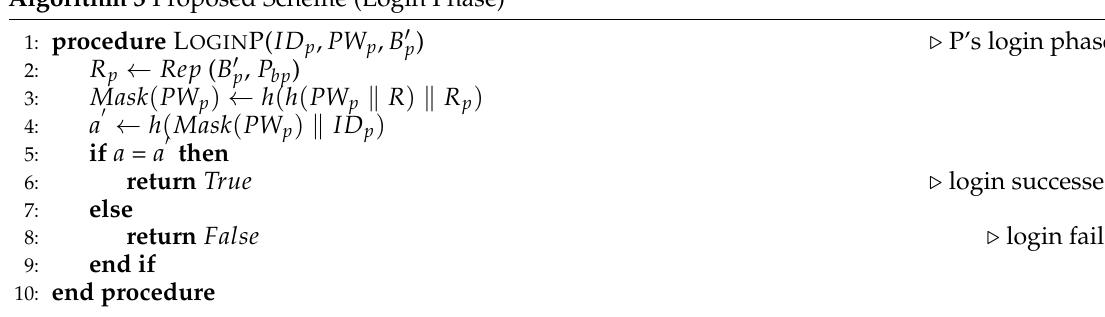
Algorithm 3 Proposed Scheme (Login